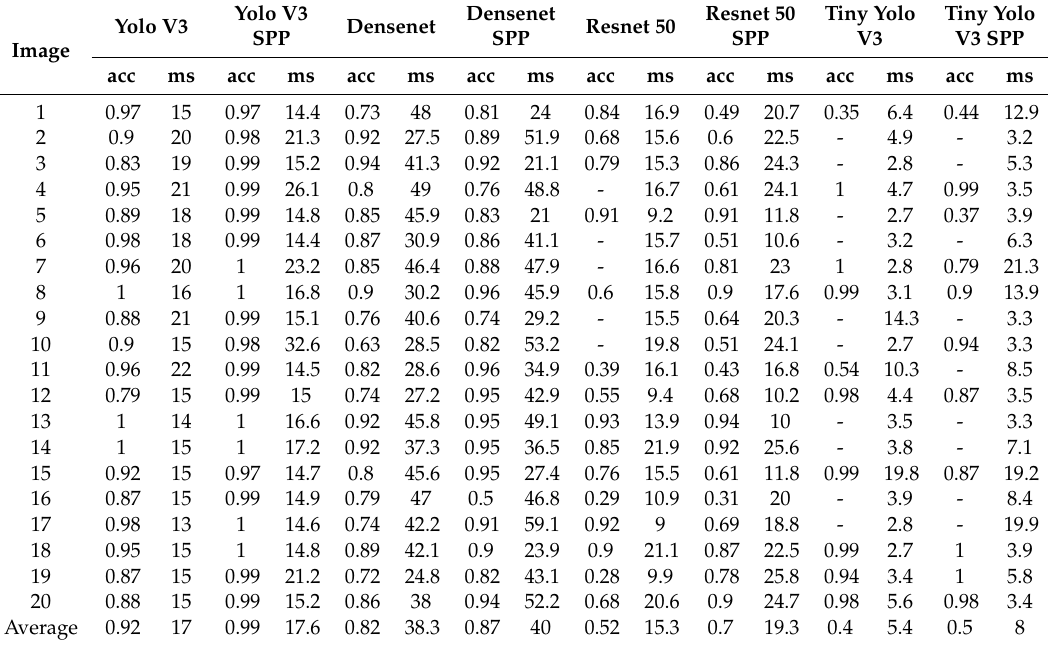
Table 3. Testing accuracy using Taiwan’s prohibitory sign images of various